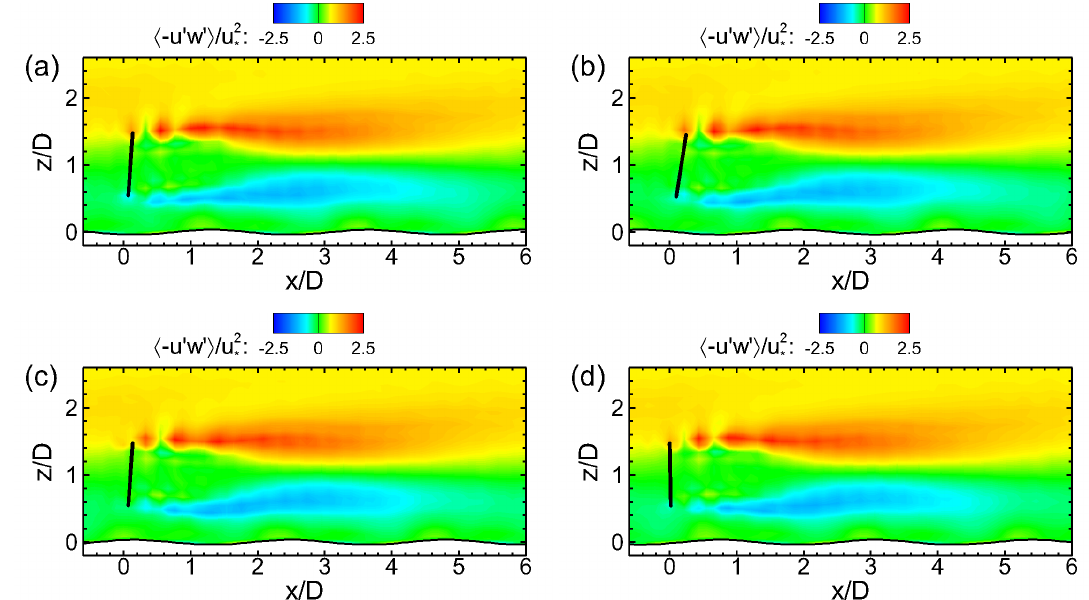
Figure 8. Swell-phase averaged Reynolds stress (cid:104)− u (cid:48) w (cid:48) (cid:105) at four representative swell phases for pitching-turbine case: ( a ) trough (Phase 1); ( b ) forward slope (Phase 2); ( c ) crest (Phase 3); and ( d ) backward slope (Phase 4). Turbine-rotor-disk location indicated by thick black